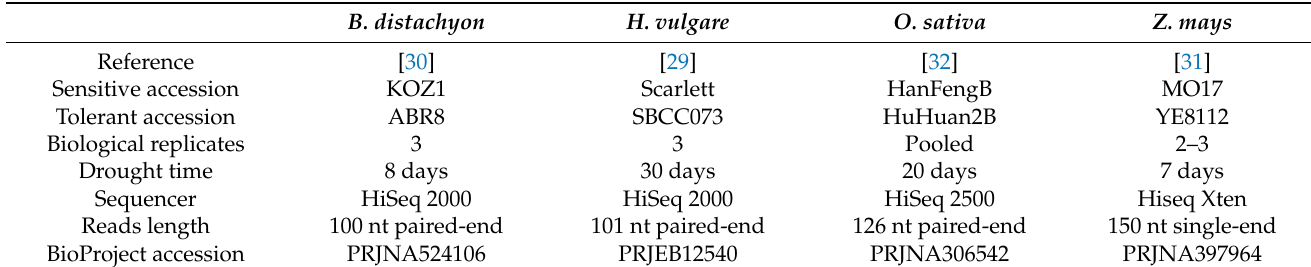
Table 1. Main features of RNA datasets used for meta-analysis. References, cultivars, biological replicates, drought stress modalities, sequencing techniques, and accessions from online repository BioProject were reported.